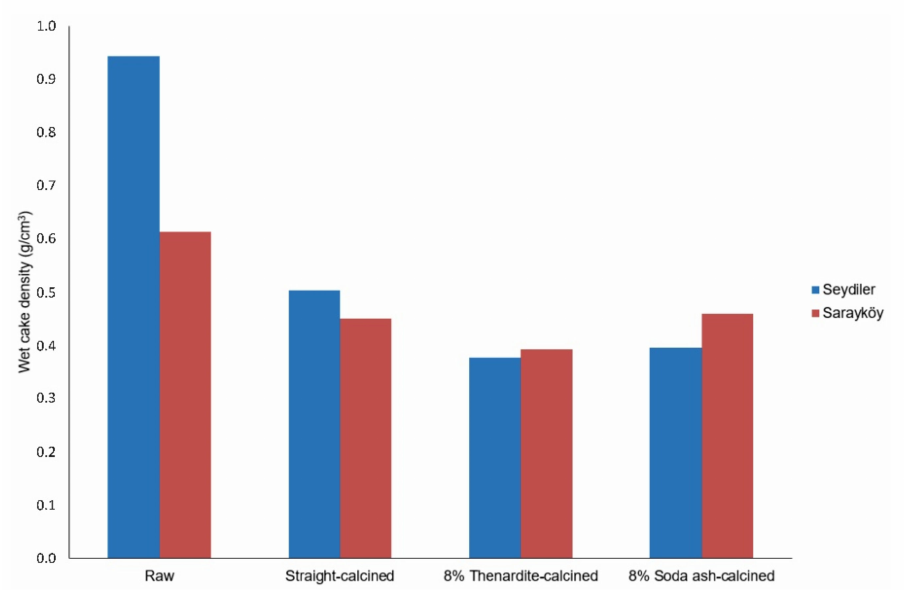
Figure 10. Wet cake density values of diatomite